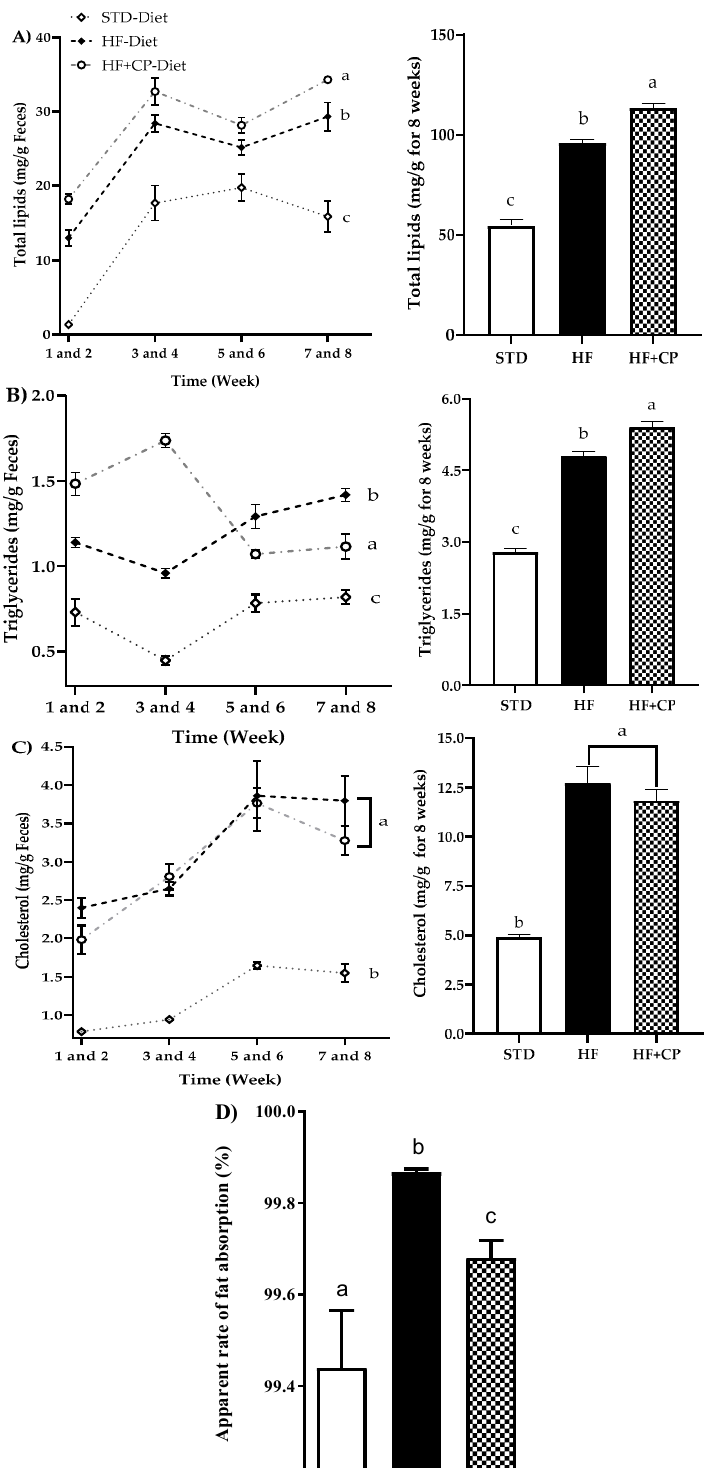
Figure 3. Levels of lipid, cholesterol, and triglycerides in feces for 8 weeks. ( A ) Total lipids in feces for 8 weeks, ( B ) triglycerides, ( C ) cholesterol in feces for 8 weeks, and ( D ) apparent absorption rate of the fat. The data are represented as mean ± standard error of the mean (SEM) ( n = 7) per group during 8 weeks of treatment. STD: standard diet, HF: high-fat diet, and HF + CP: high-fat diet + 150 mg/kg/day cocoa protein. a, b, c indicate significantly different values ( p < 0.05).